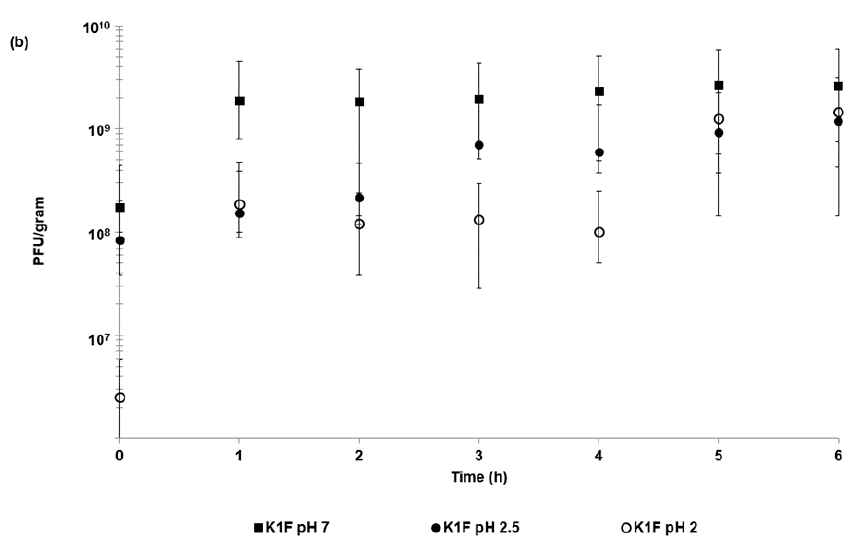
Figure 5. Release of encapsulated bacteriophages from ES100 / Alg (EK1F) microparticles: ( a ) Total phage release from EK1F microparticles after 6 h exposure to Simulated Intestinal Fluid (SIF) at pH 7 with and without exposure to Simulated Gastric Fluid (SGF) at pH 2 and pH 2.5 (exposure to SGF for 2 h). The black squares represent the % phage release compared to microparticles not exposed to SGF (pH 7). ( b ) Phage release kinetics from EK1F microparticles over a 6 h exposure period to SIF at pH 7 without and with exposure to SGF at pH 2 and pH 2.5.